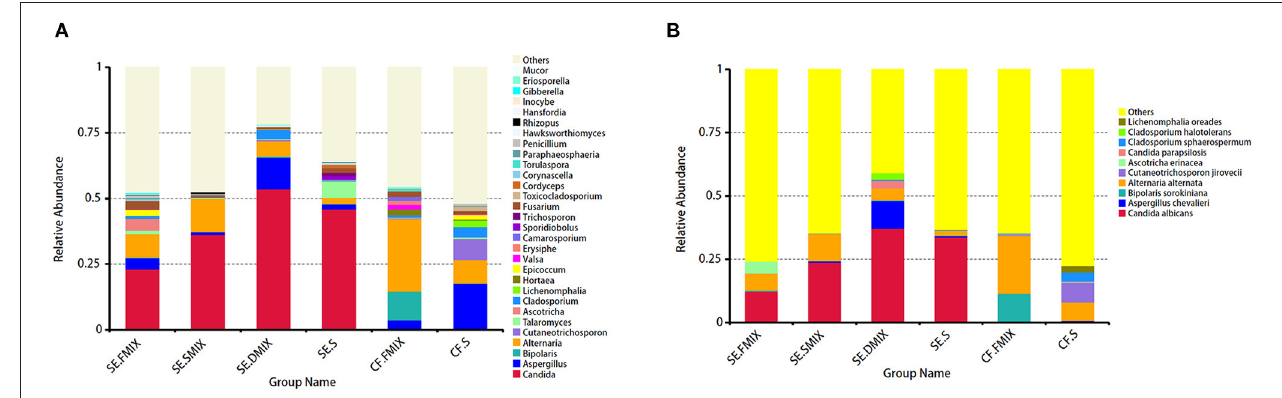
FIGURE 3 | Distribution of fungal profiles in children with S-ECC and caries-free. (A) At the genus level, top 30 taxa for each category. (B) Top 10 fungal species in the six categories.